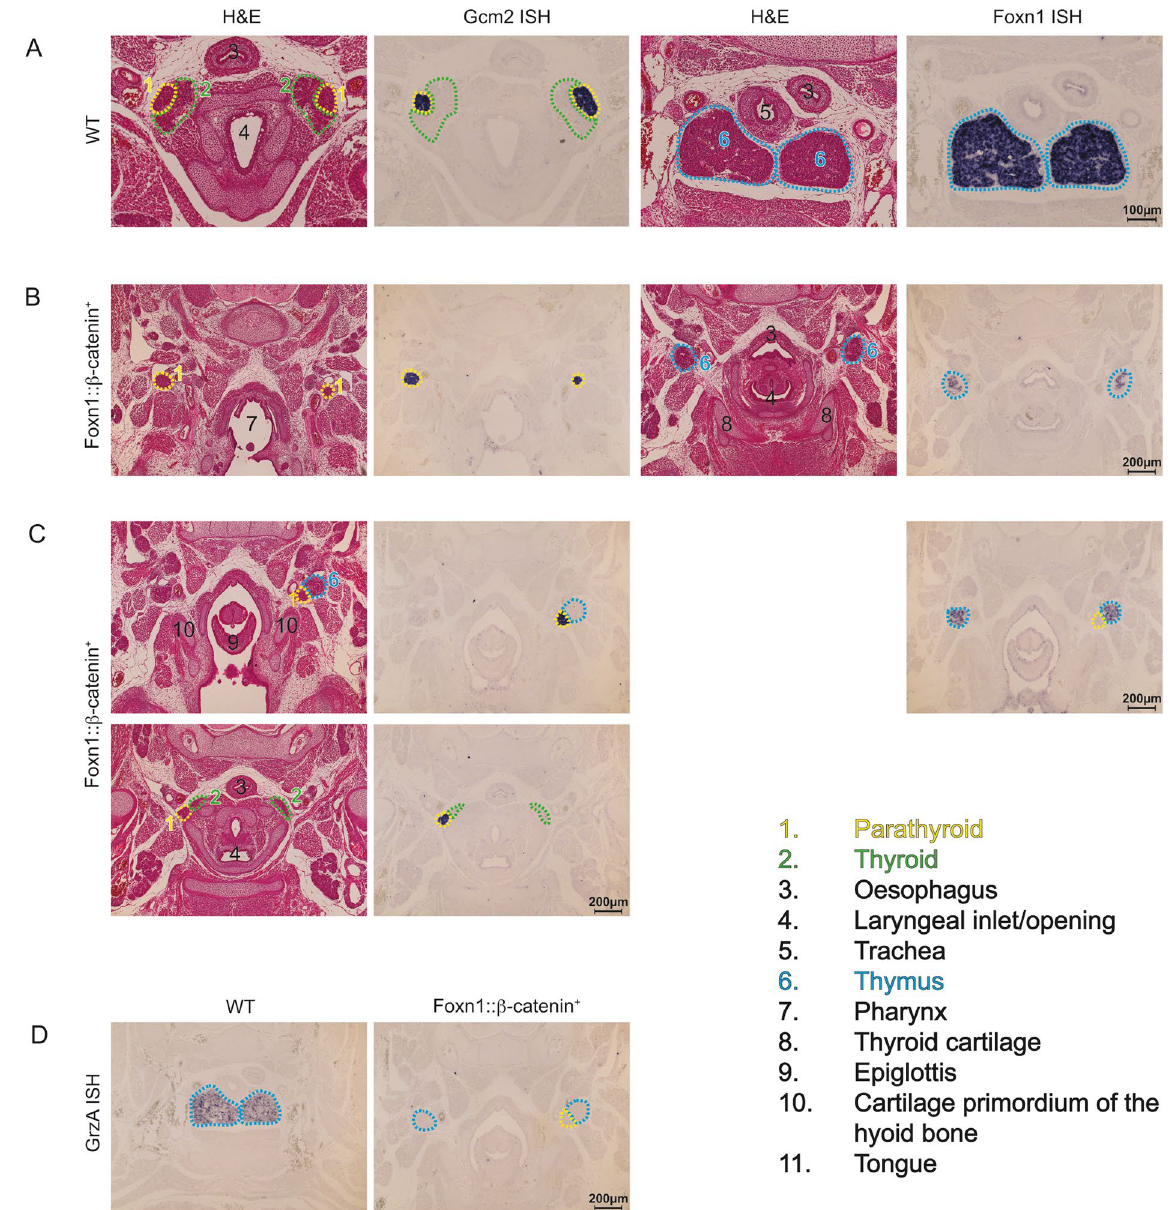
Figure 3. TEC-intrinsic β -catenin overexpression disrupts thymus and parathyroid development. ( A ) Development of the parathyroid and thymus of wild-type mice at E15.5 examined by H&E staining and RNA in situ hybridization with the indicated gene-specific probes. ( B ) Development of the parathyroid and thymus of mutant mice at E15.5 examined as in ( A ). ( C ) Development of the parathyroid and thymus of mutant mice at E15.5 examined as in ( A ); sections are derived from the same embryo, with the top row depicting the ectopic location of the left parathyroid lobe and the thymic lobes (approximately at the level of the pharyngeal inlet), and the second row demonstrating the position of the right parathyroid in the expected position at the anterior pole of the thyroid. The numerical figure label key applies to all figures. In ( A – C ), H&E stained sections are matched with corresponding sections subjected to RNA in situ hybridization. ( D ) RNA in situ hybridization with a GrzA probe to detect developing